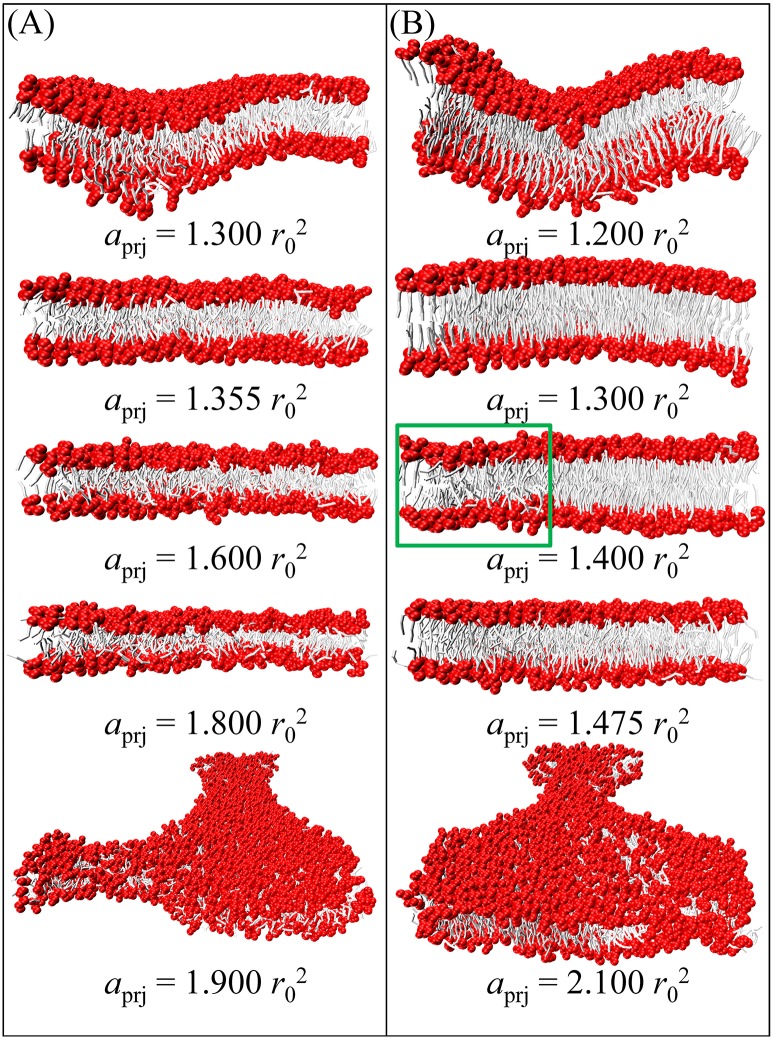
Snapshots of (A) fluid phase DMPC and (B) gel phase DPPC lipid bilayers at various aprj.